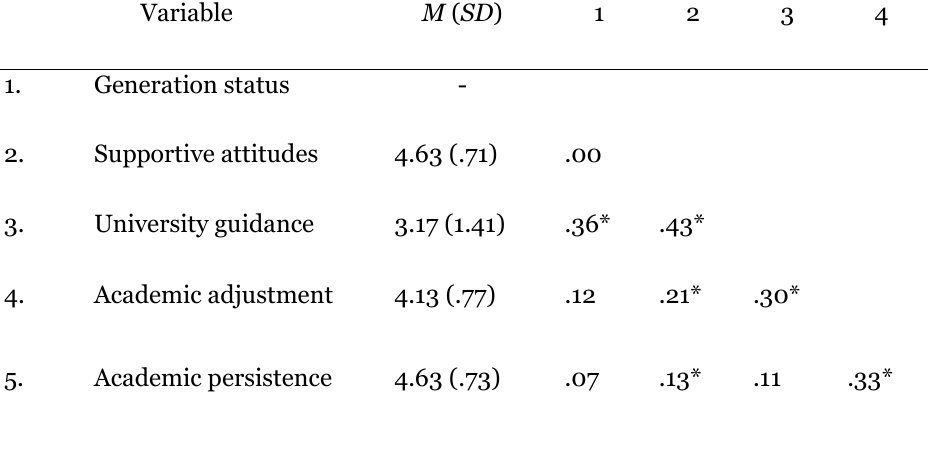
Means, Standard Deviations, and Correlations of Family Resources and Academic Outcomes